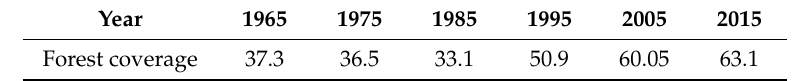
Table 6. The change of forest coverage (%) in Ganjiang River Basin in the past